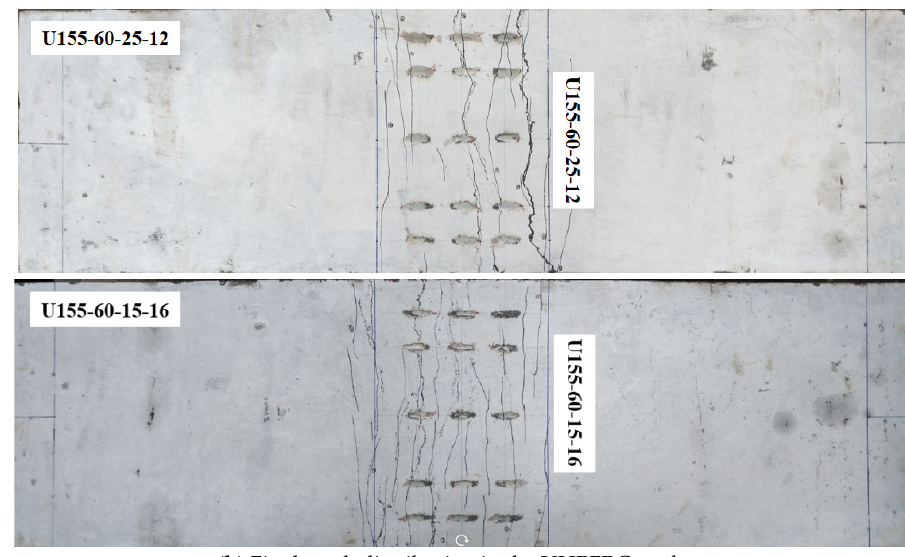
Figure 12. Final crack distribution of some components.